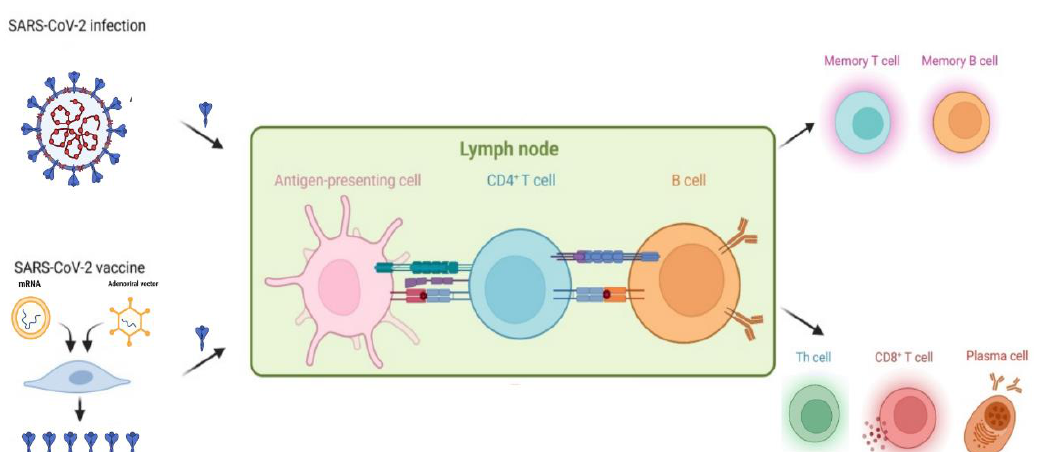
Figure 1. Infection- or vaccination-induced immune protection against SARS-CoV-2.